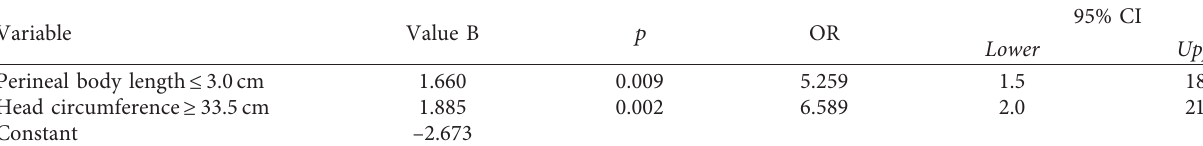
Table 6: Logistic regression analysis using backward